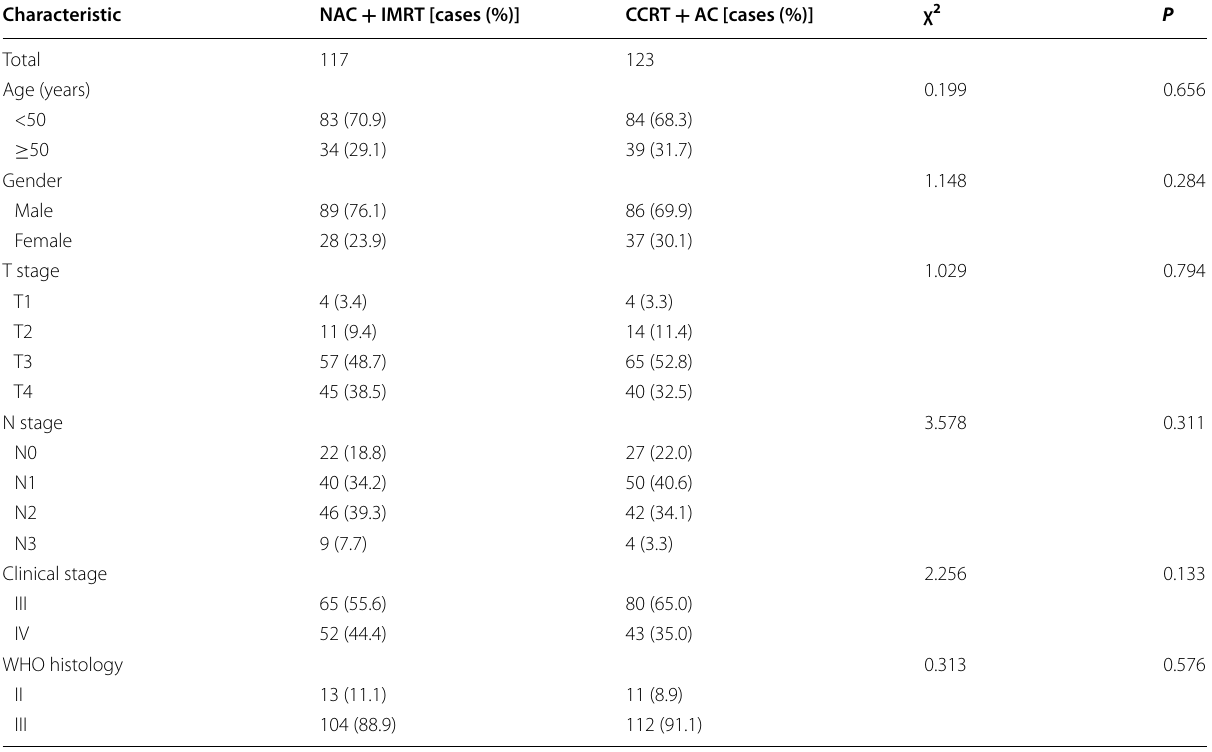
Table 1 Characteristics of the 240 patients with locoregionally advanced nasopharyngeal carcinoma (NPC)